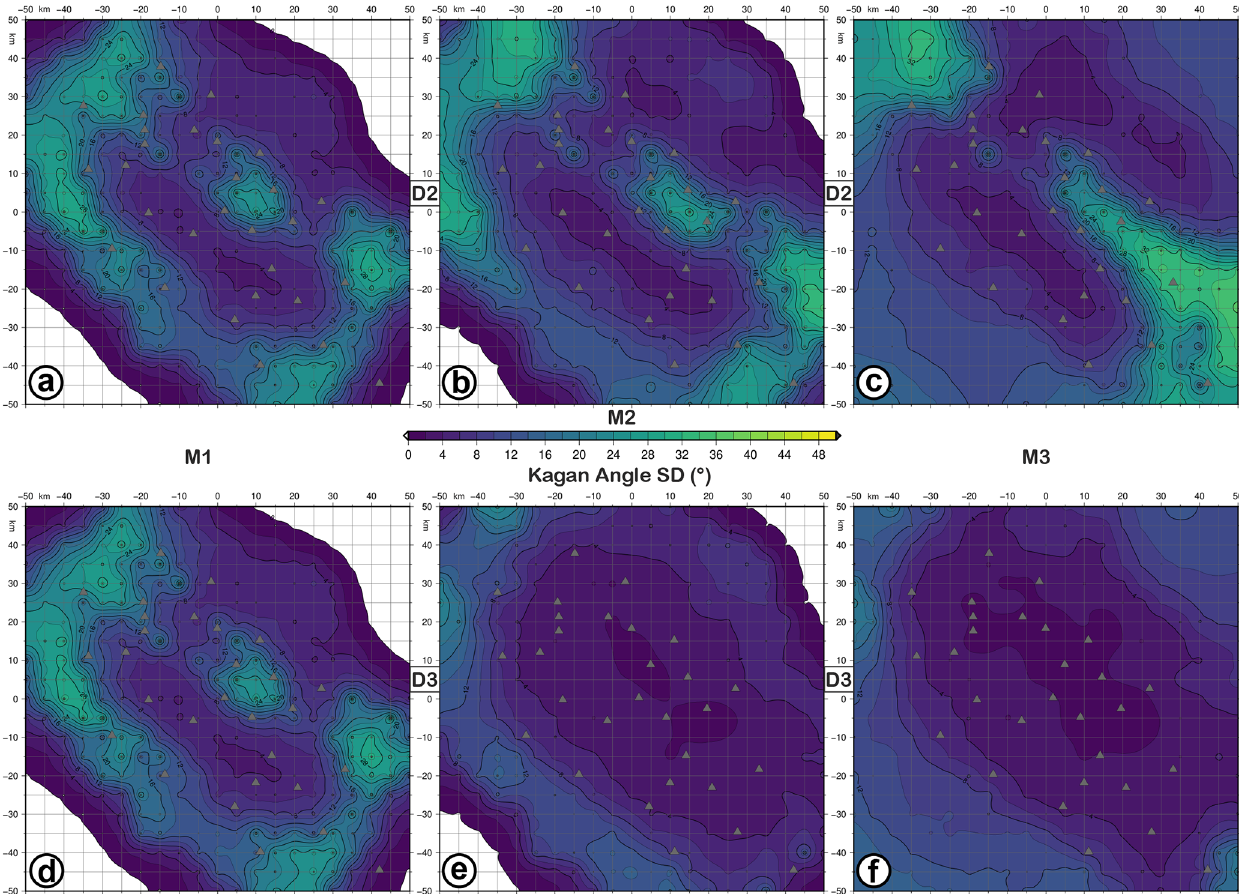
Figure 8. KAS (Kagan angle standard deviation) maps for retrieved focal mechanisms with D2 (a–c) and D3 (d–f) datasets as input data and simulating earthquakes with M1 (a, d) , M2 (b, e) , and M3 (c, f) magnitudes and the FM1 theoretical fault plane solution at 10km depth. The level of Gaussian noise is set to 5%.